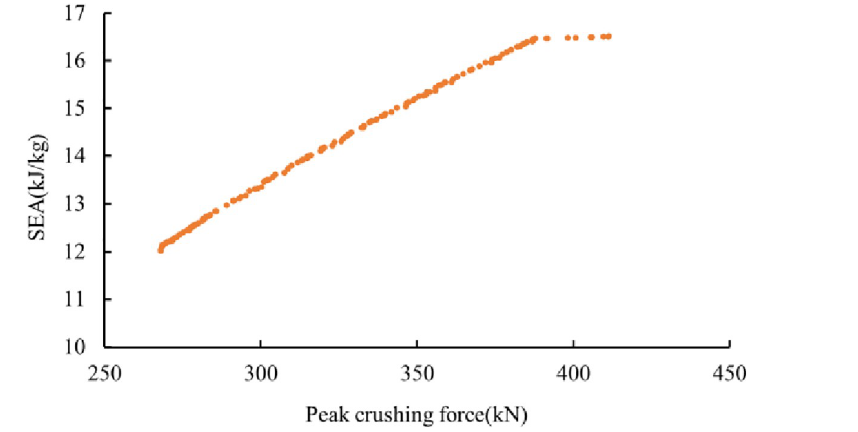
Fig 12. The Pareto front of the multi-cell tubes under axial crushing